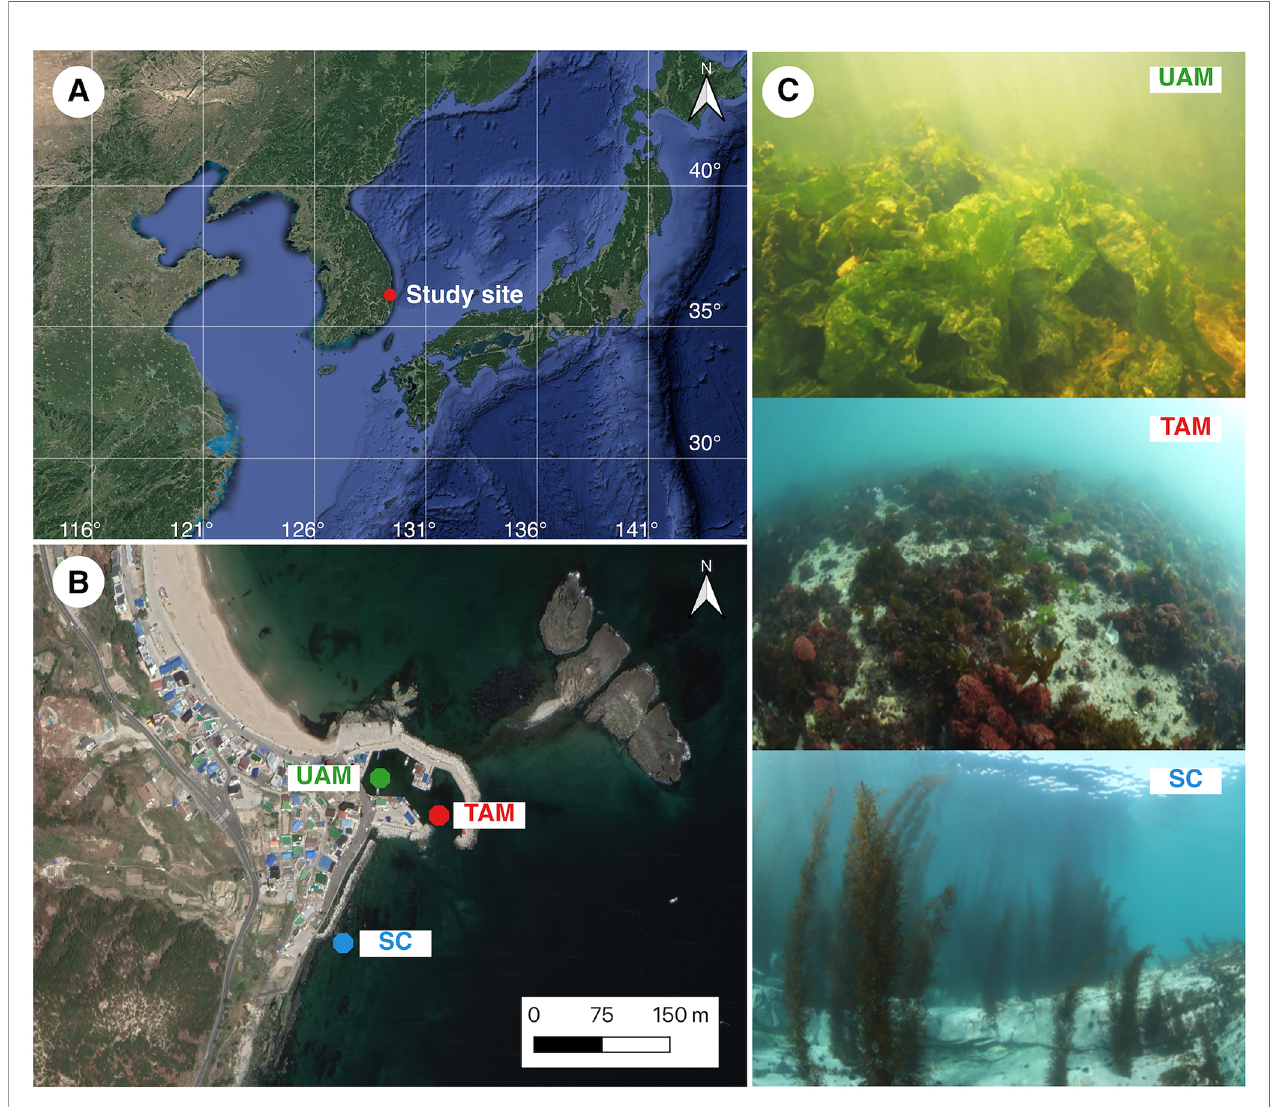
FIGURE 1 | (A) The location of study area where the three sites with different macroalgal habitats were located in Odo beach of Pohang on the east coast of the Korea peninsula, (B) locations of the three study sites with different macroalgal habitats (UAM, ulvoid algal mat; TAM, turf algal mat; SC, coexisting Sargassum horneri and crustose coralline algae) and (C) photographs of three macroalgal habitats (UAM: top, TAM: mid, and SC: bottom). Maps were generated using a Google satellite map and QGIS 3.20 Odense software (QGIS Development Team,